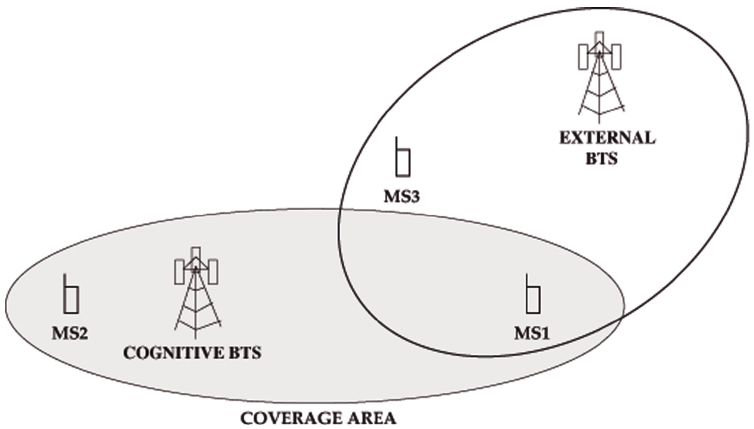
Figure 6. Hidden node